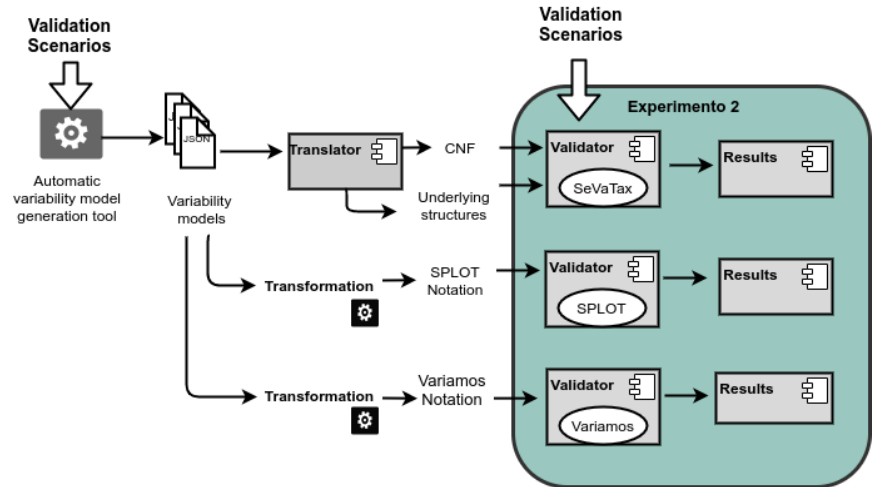
Figure 20. Experiment 2—Workflow for coverage